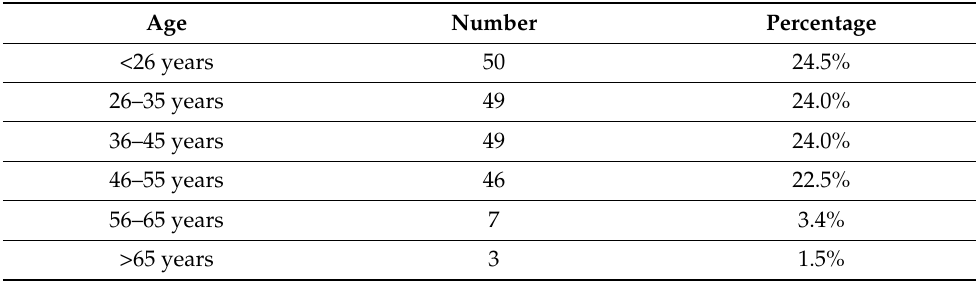
Table 1. Age of respondents.